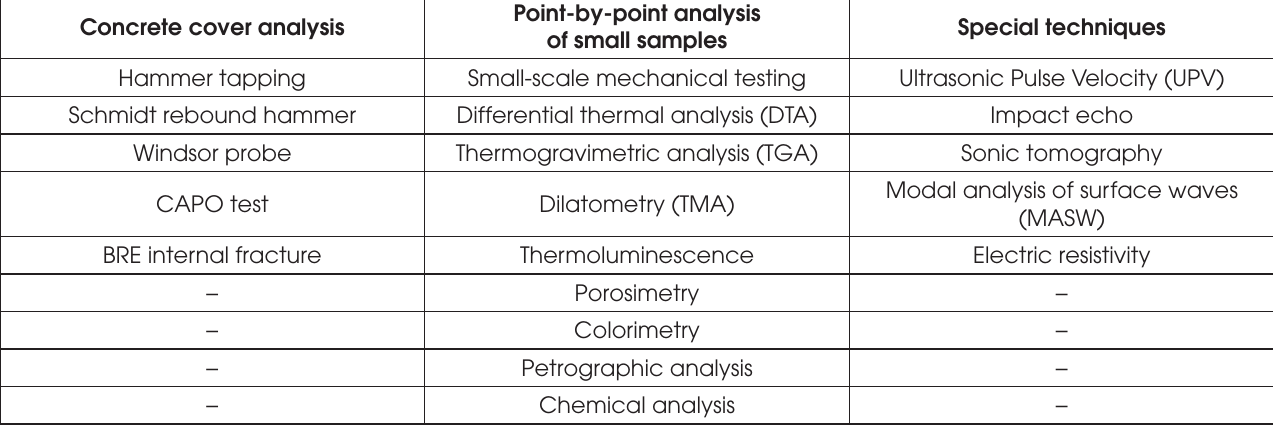
Non-destructive testing applied to fire damaged concrete (adapted